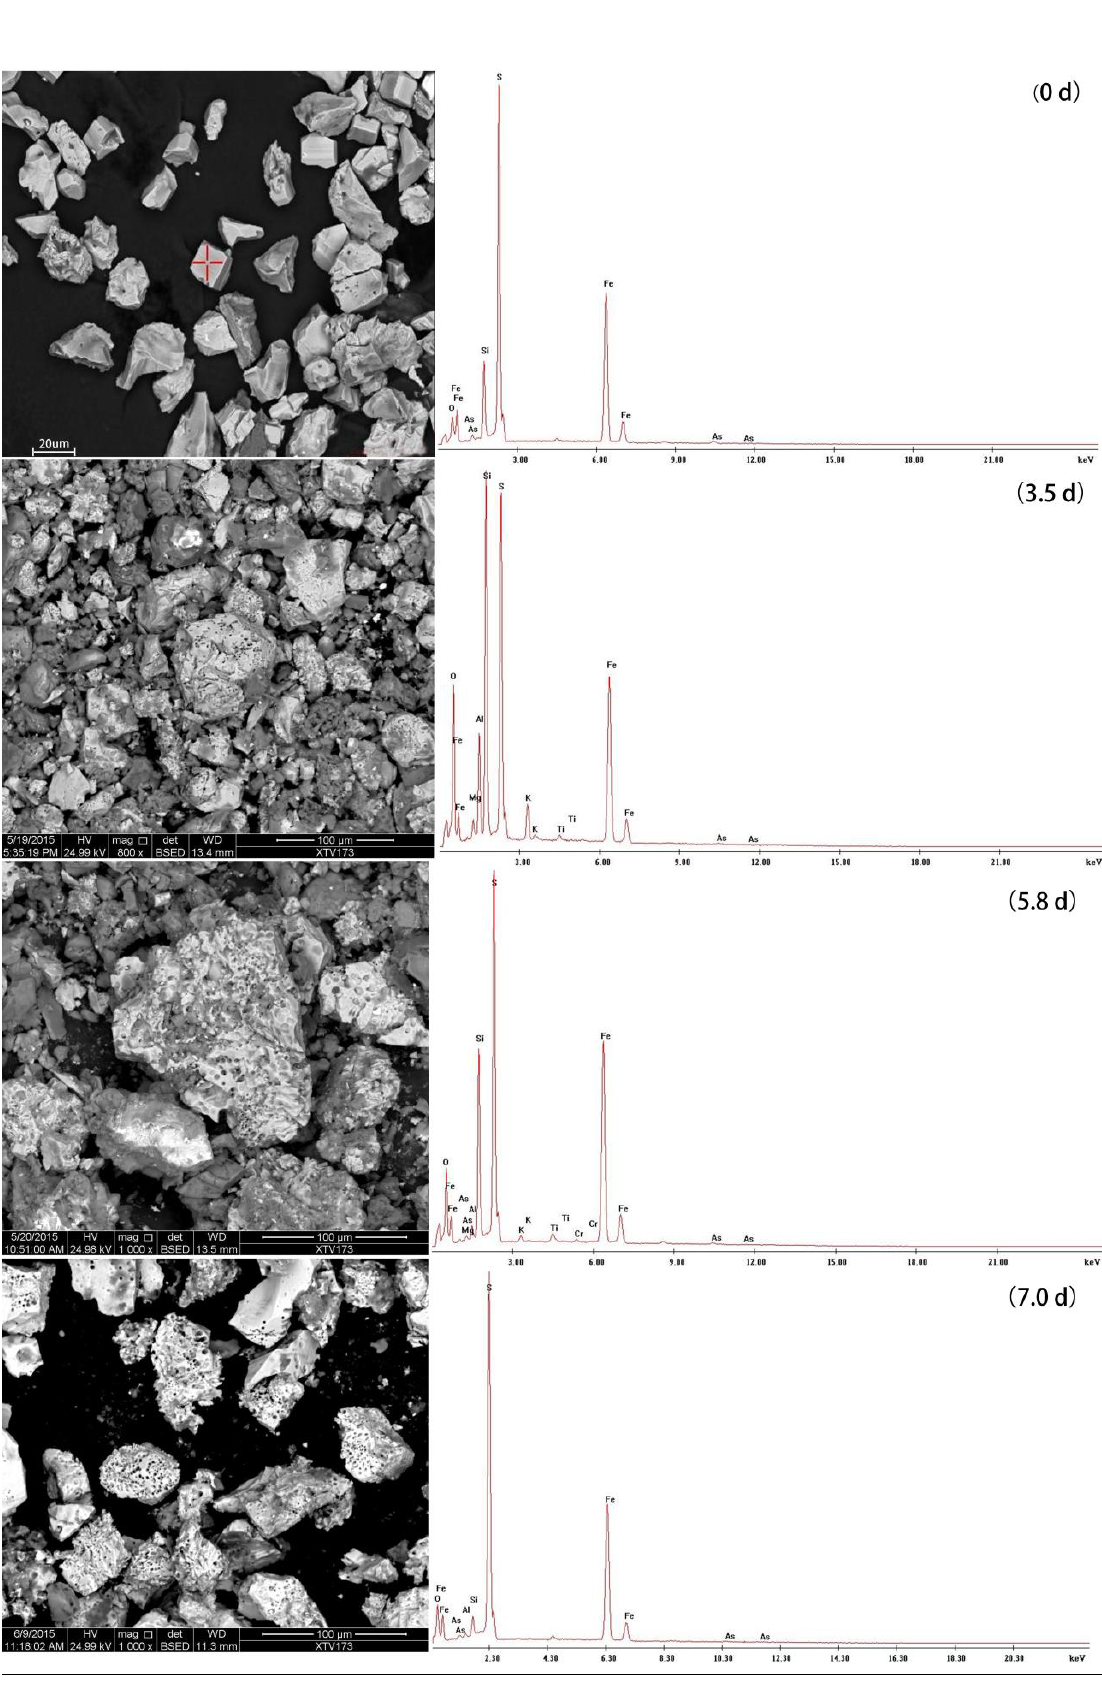
Figure 8. SEM and EDX of residue during continuous bio-oxidation procedure.